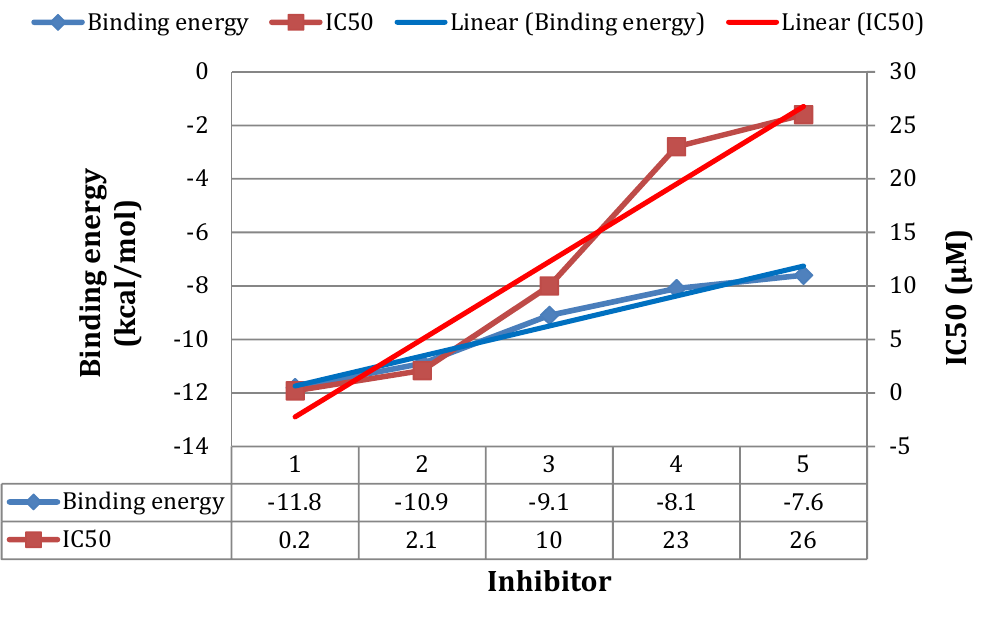
Figure 8. The binding energies determined in our study and were compared against IC values for the compounds assayed. The higher the binding affinity, the higher the IC